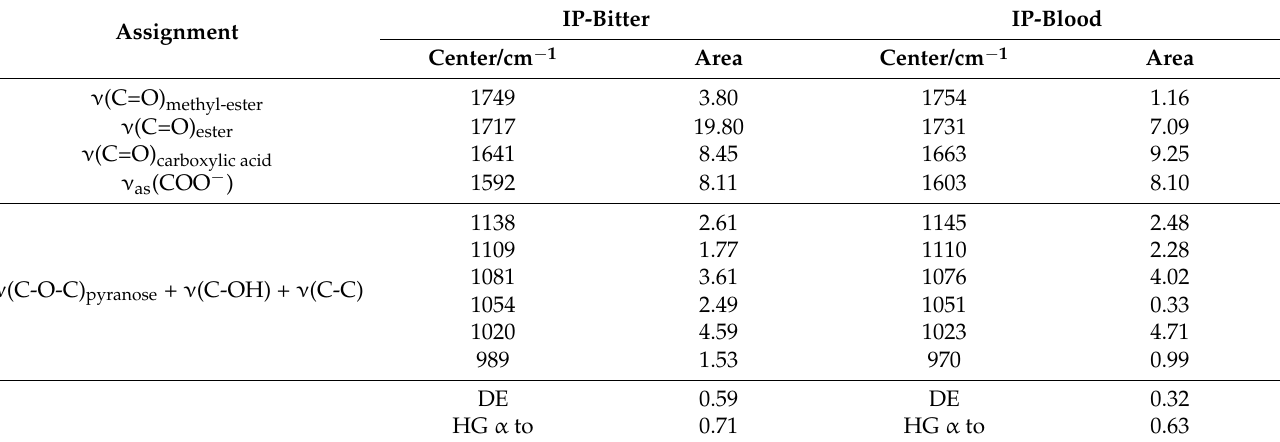
Table 2. Decomposition results of the 850–1800 cm -1 region of the DRIFT